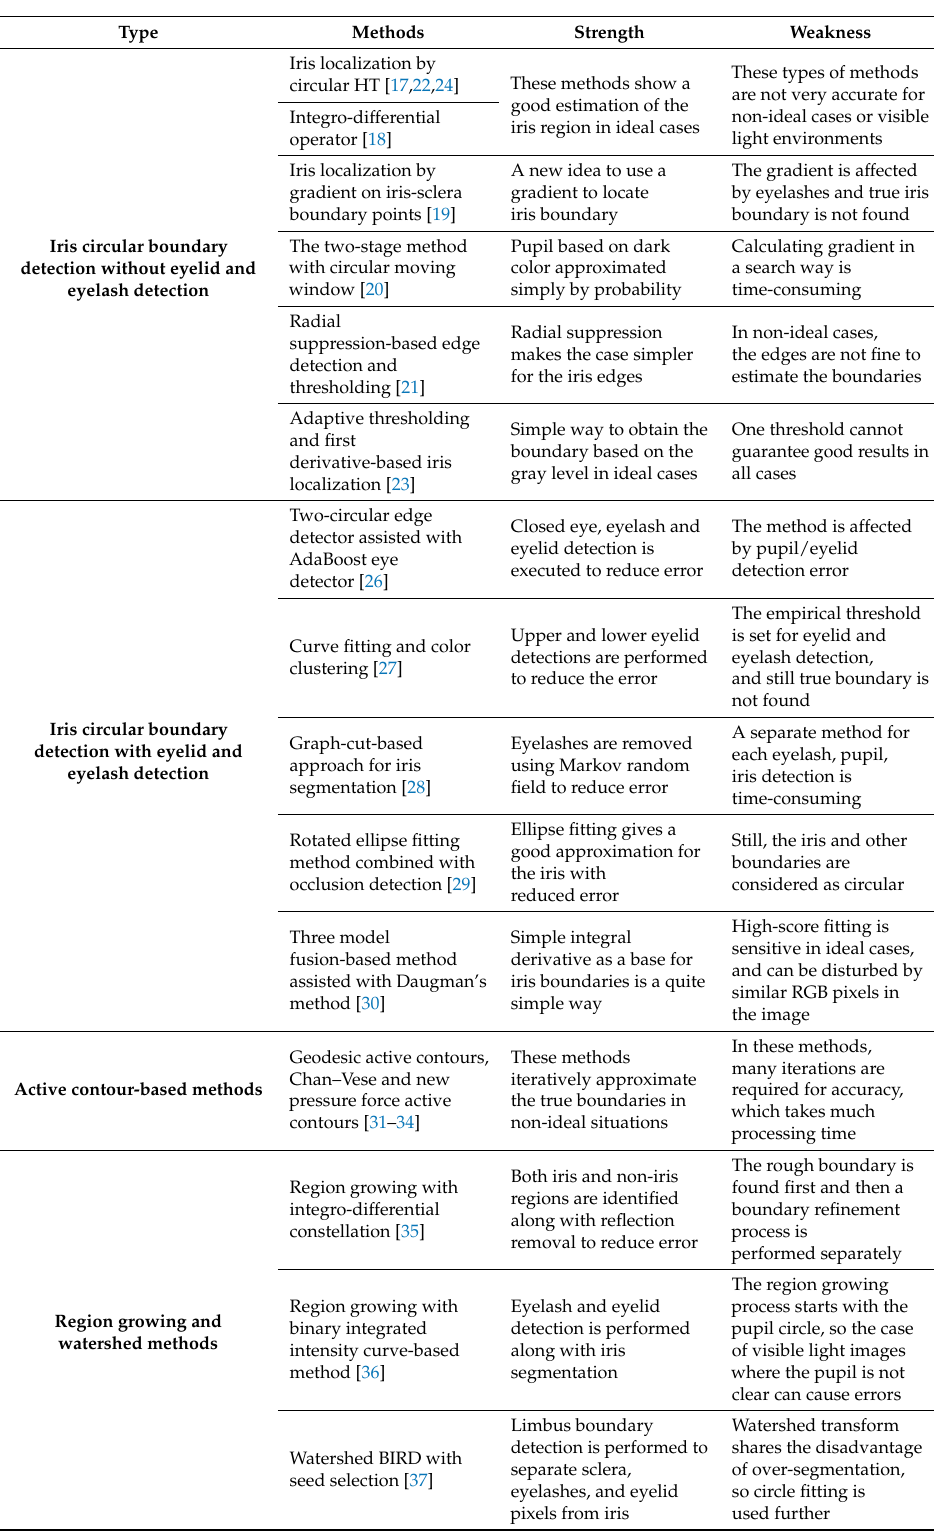
Table 1. Comparisons between the proposed and existing methods for iris